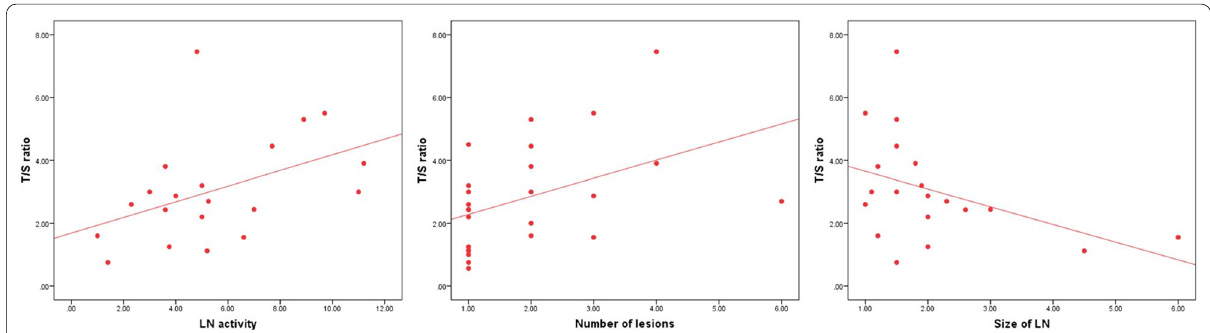
Fig. 10 Correlation between TSR and LN activity, number of breast lesions and the size of the